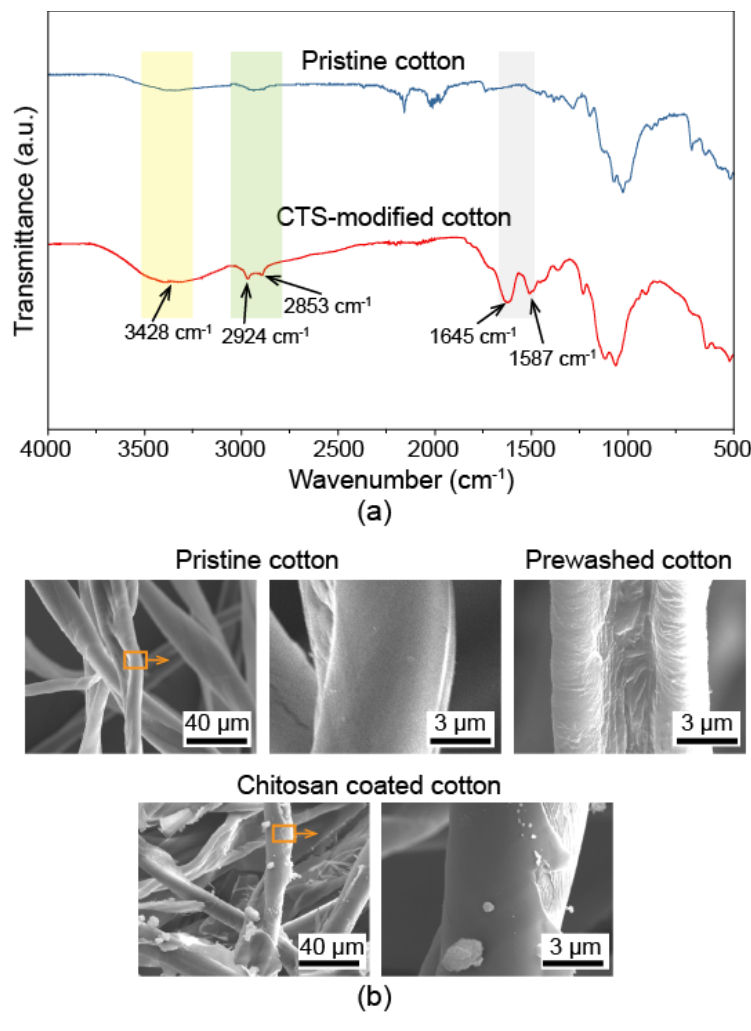
Figure 2. ( a ) FTIR spectra of pristine and CTS-coated cotton. ( b ) SEM morphology of pristine, pre-washed and CTS-coated cotton.